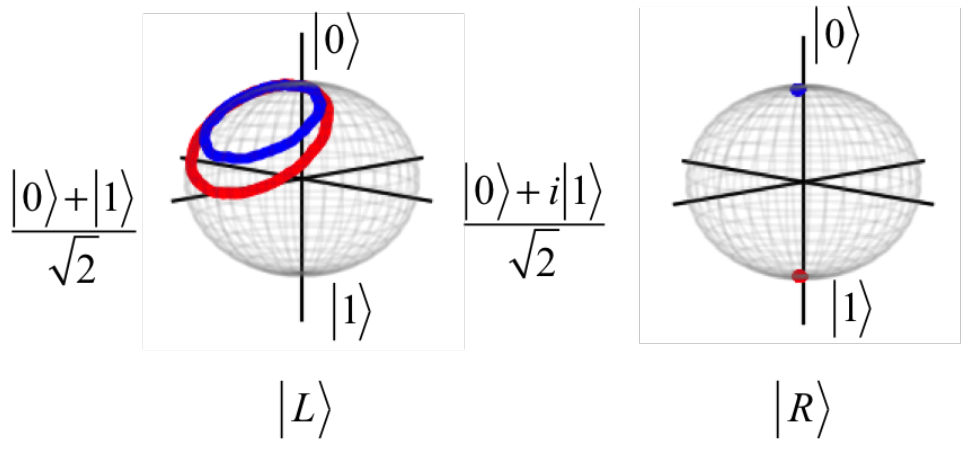
Figure 9. The dynamics of states | L (cid:105) and | R (cid:105) displayed in the Bloch sphere for the left and right qubits, corresponding to Figure 8. The solution of the composite system is written as a product state | Ψ ps (cid:105) = | L (cid:105) ⊗ | R (cid:105) . Red and blue colors are the trajectories of the initial states | 01 (cid:105) and | 00 (cid:105) , respectively. The right qubit state | R (cid:105) is fixed in either | 0 (cid:105) r or | 1 (cid:105) r as a control